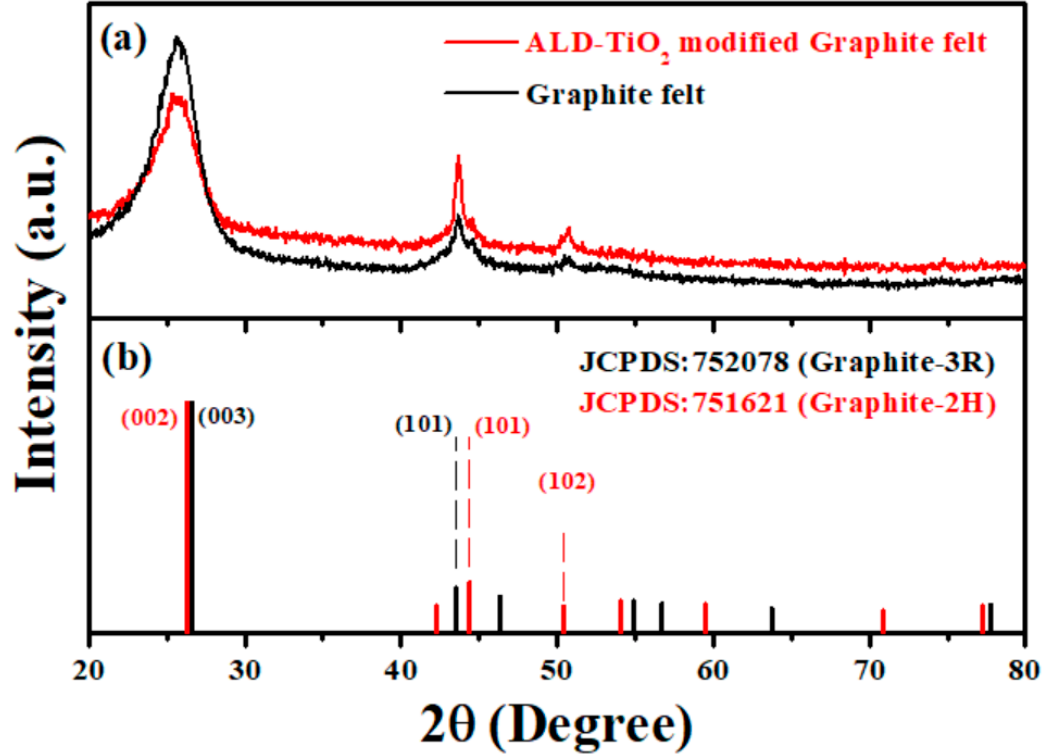
Figure 5. ( a ) XRD patterns of original graphite felt and ALD-TiO 2 modified graphite felt, ( b ) JPCDS cards of Graphite-3R and Graphite-2H.